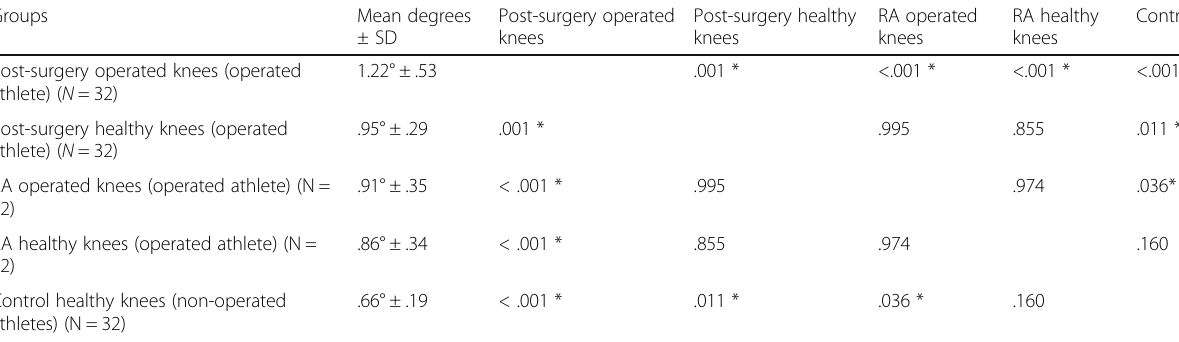
Table 3 Kinaesthetic sense and statistical analysis of both knees in operated and non-operated athletes